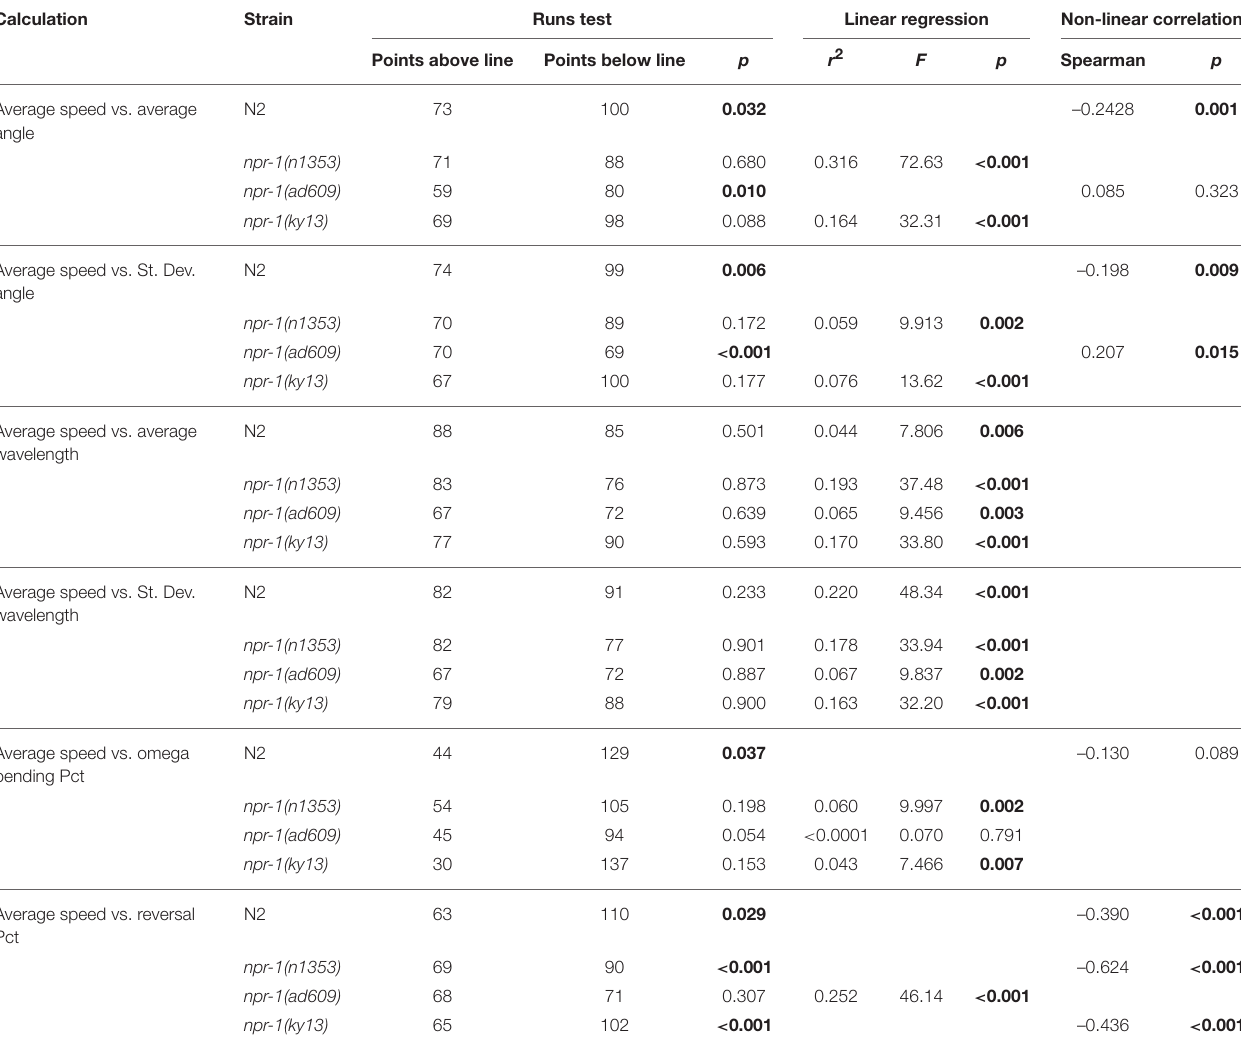
TABLE 4 | Summary of correlation between analyses for worms on plates with no lawn. Calculation Strain Runs test Linear regression Non-linear correlation Points above line Points below line p p Spearman p Average speed vs. average